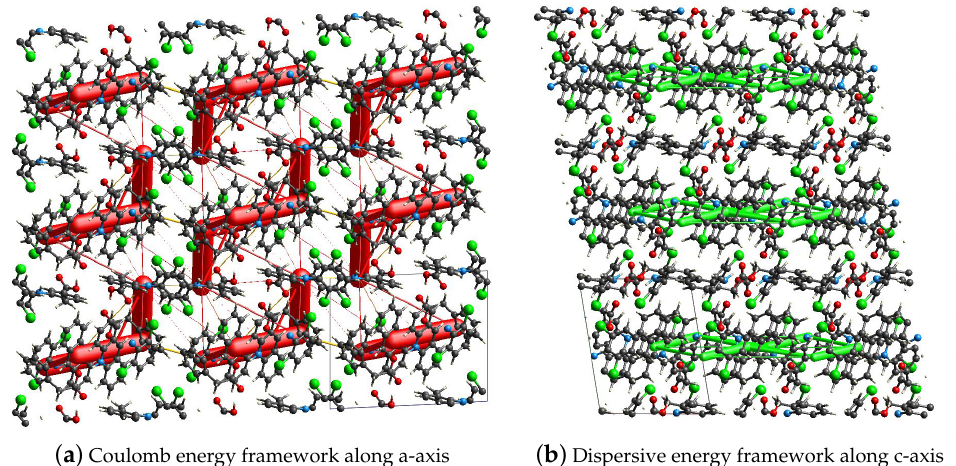
Figure 5. Energy frameworks calculated for the 1:2 single crystal-solved